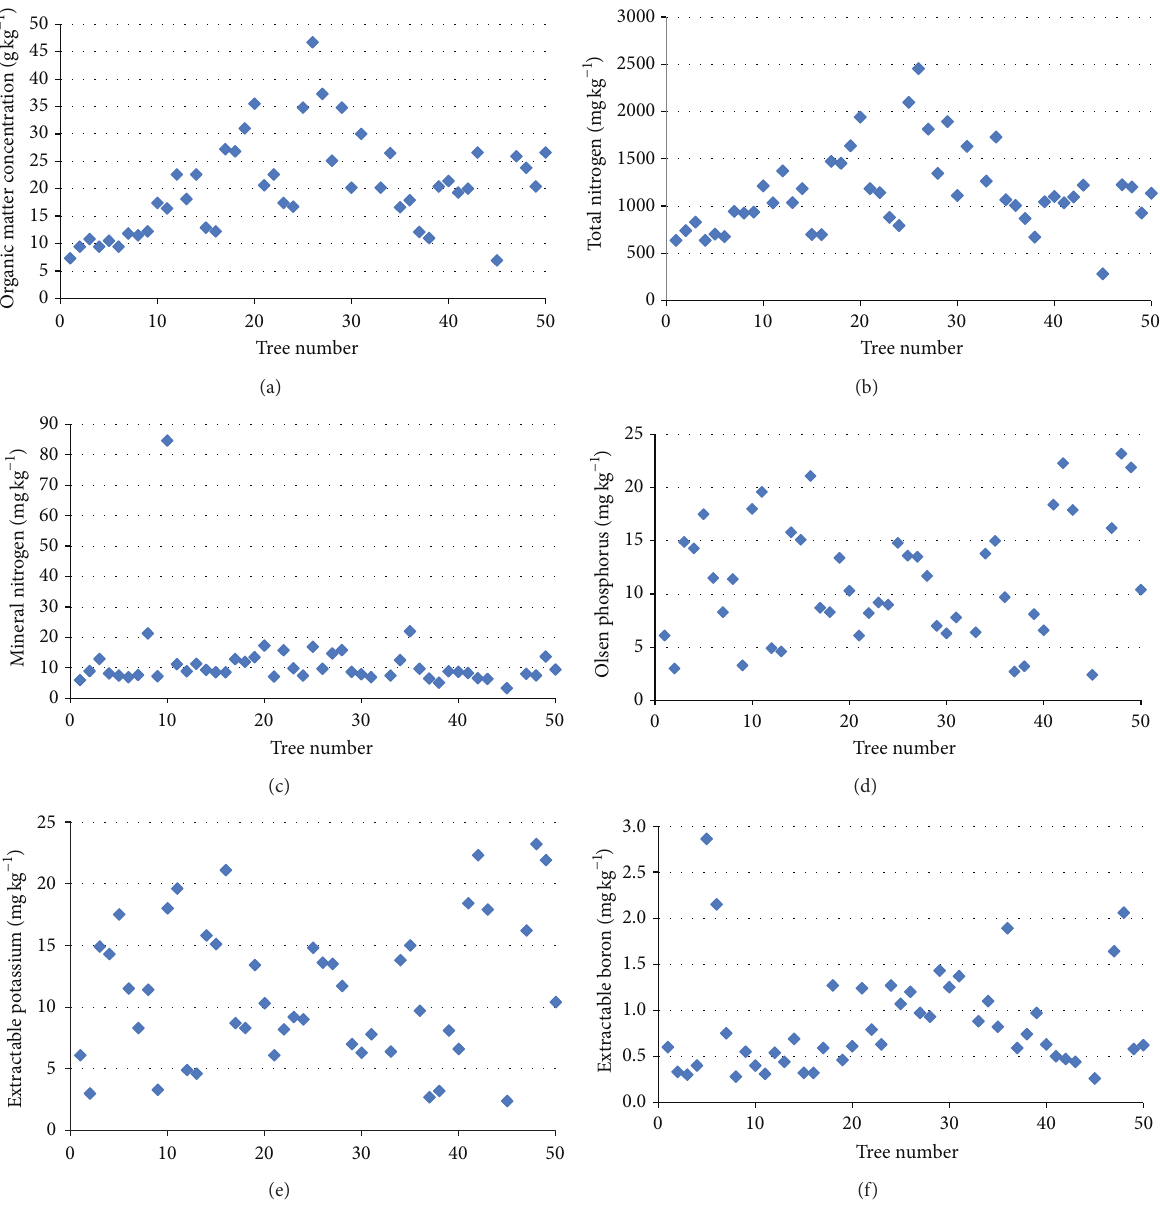
Figure 2: Fertility levels in the topsoil (0–20cm): (a) organic matter, (b) total nitrogen, (c) mineral nitrogen, (d) Olsen phosphorus, (e) extractable potassium, and (f) extractable